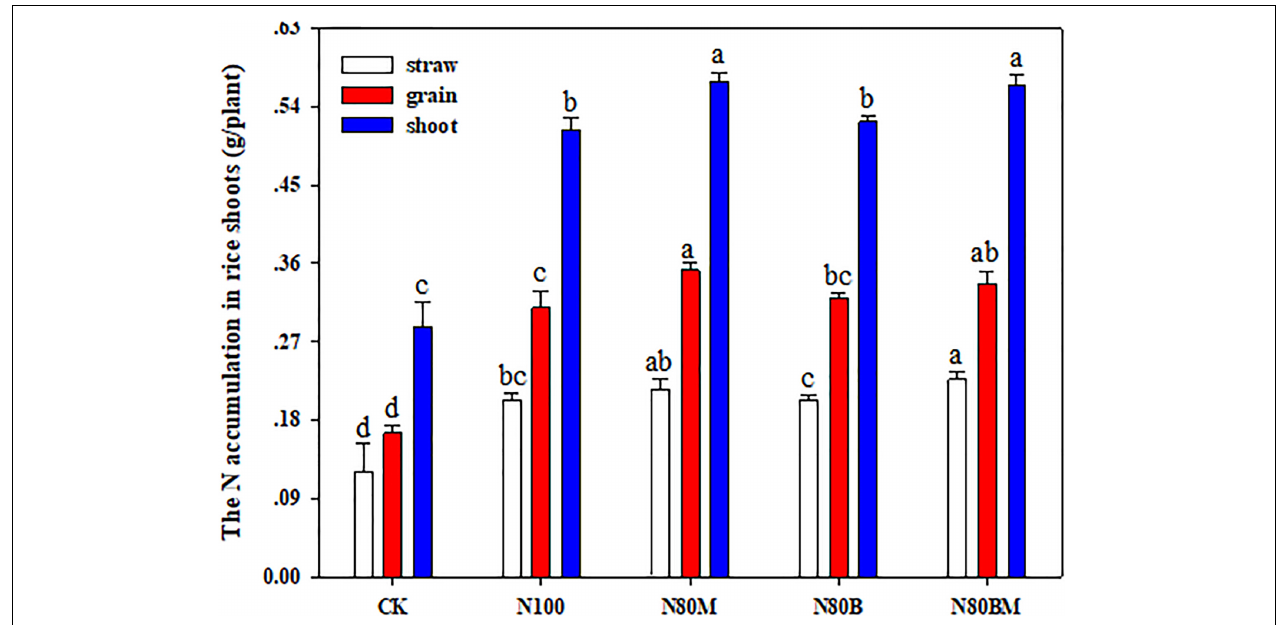
FIGURE 3 | Effects of applying rice straw biochar and leguminous cover crop residue on the N accumulation in rice plant shoot at maturing stage. Small bars are standard errors. Values followed by different letters in the same color are significantly different at P < 0.05.